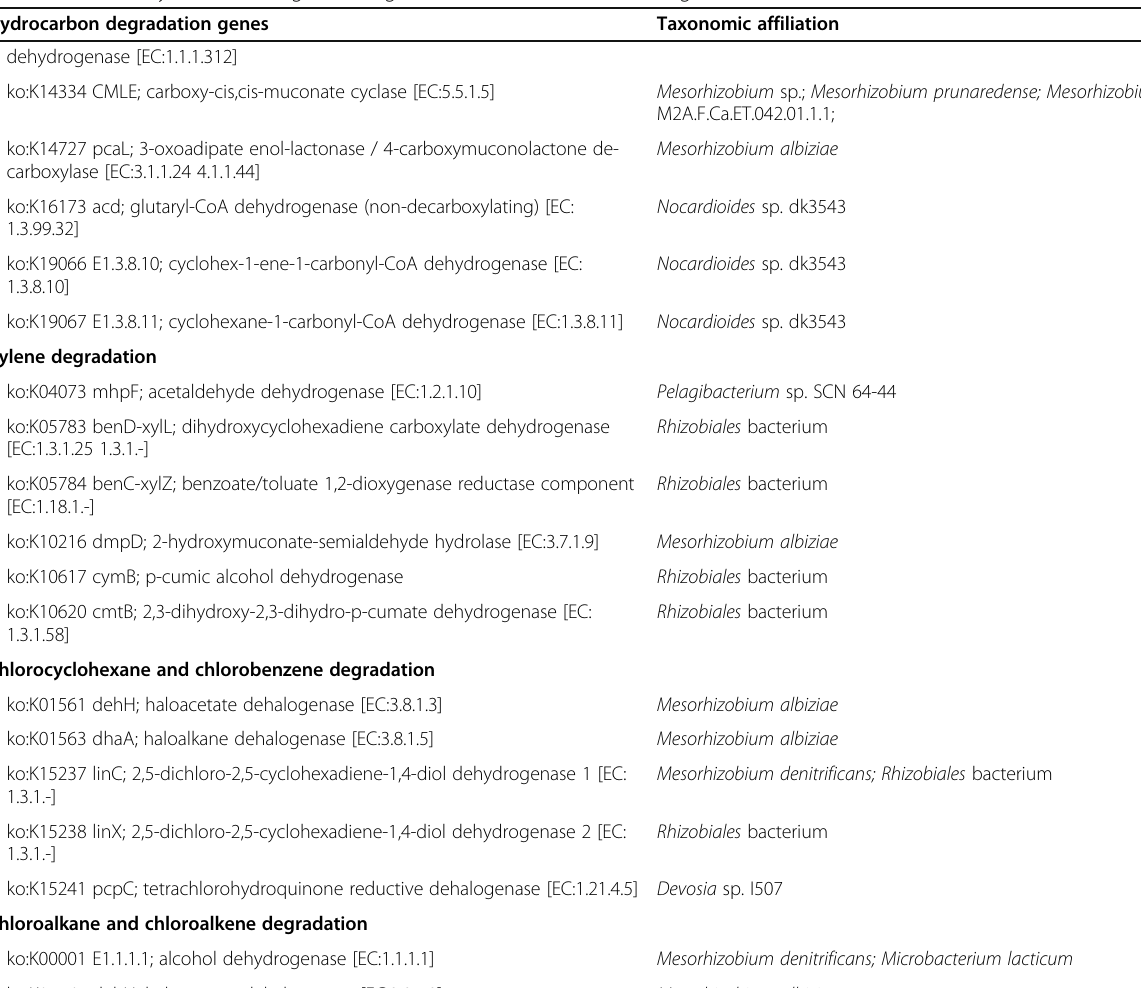
Table 2 Putative hydrocarbon degradation genes detected in the FN1 metagenome and their taxonomic affiliation (Continued) Hydrocarbon degradation